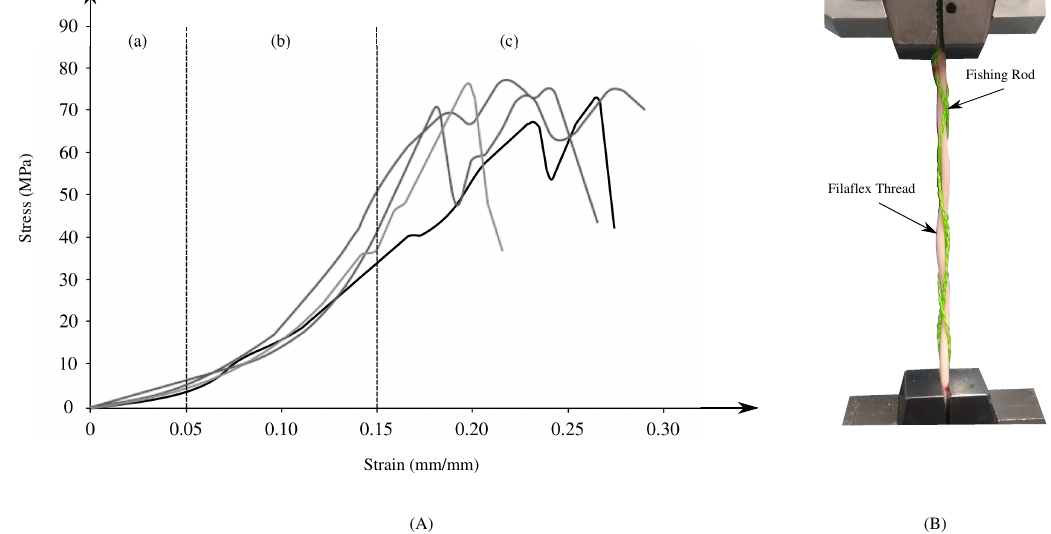
Figure 4. ( A ) Stress–strain curve behavior of elastic tendons integrated in the T-Flex robotic orthosis. Stress–strain curve exhibits similar behavior to the human tendon, where the three characteristic regions (elastic, linear and failure) are observed. An average maximum strain before failure of 15%, average failure stress obtained of 75 MPa, and modules in 150–510 MPa range are found for the combined material; ( B ) material configuration and experiment setup for tensile